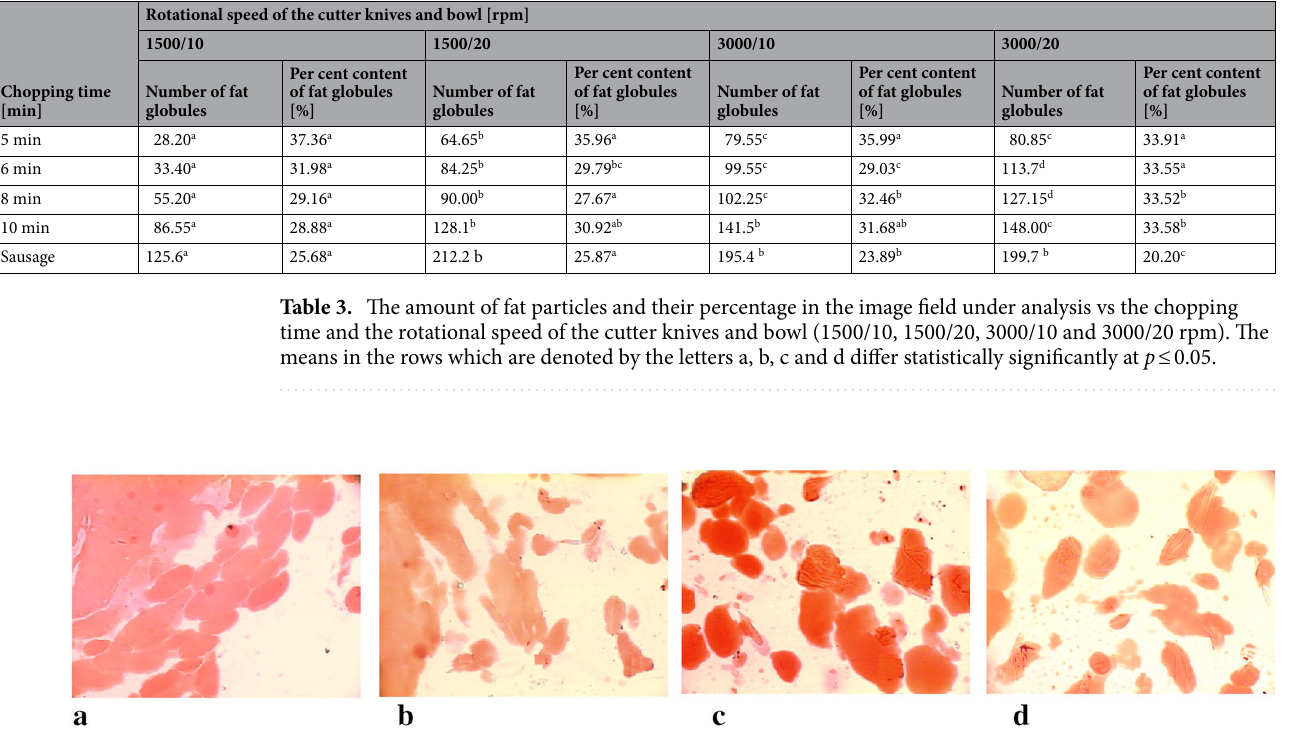
Figure 1. Microstructure of batter (x200) (fat globules) after 5 min chopping produced with varying rotational speed of chopper knives and bowl ( a ) −1500/10 rpm −1 , ( b ) −1500/20 rpm −1 , ( c ) −3000/10 rpm −1 , ( d ) −3000/20 rpm −1